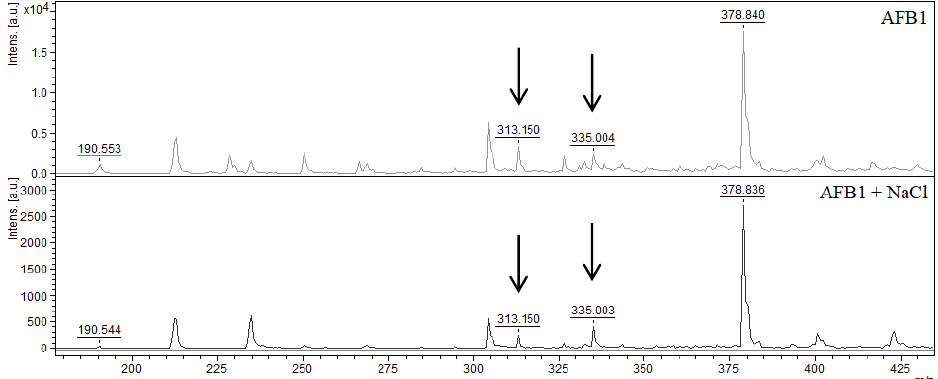
Figure 1. MALDI-TOF mass spectra of AFB 1 presented as tandem peaks with mass spectrum of 313.150 m/z [M + H] + and 335.004/335.003 m/z [M + Na] + .Peaks are indicated with arrows.